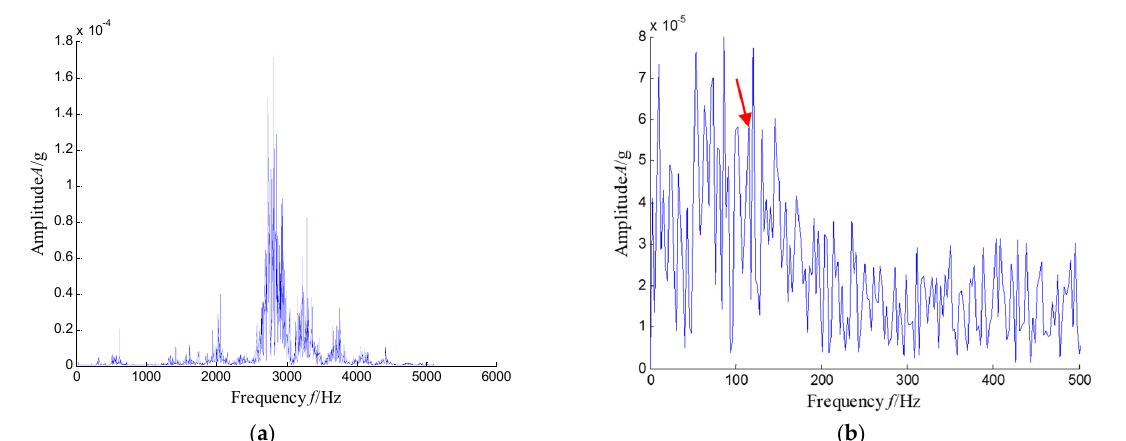
Figure 34. Spectrum and envelope spectrum of the 3rd subspace obtained by the RSVD method: ( a ) spectrum of the reconstructed signal and ( b ) envelope spectrum of the reconstructed signal.